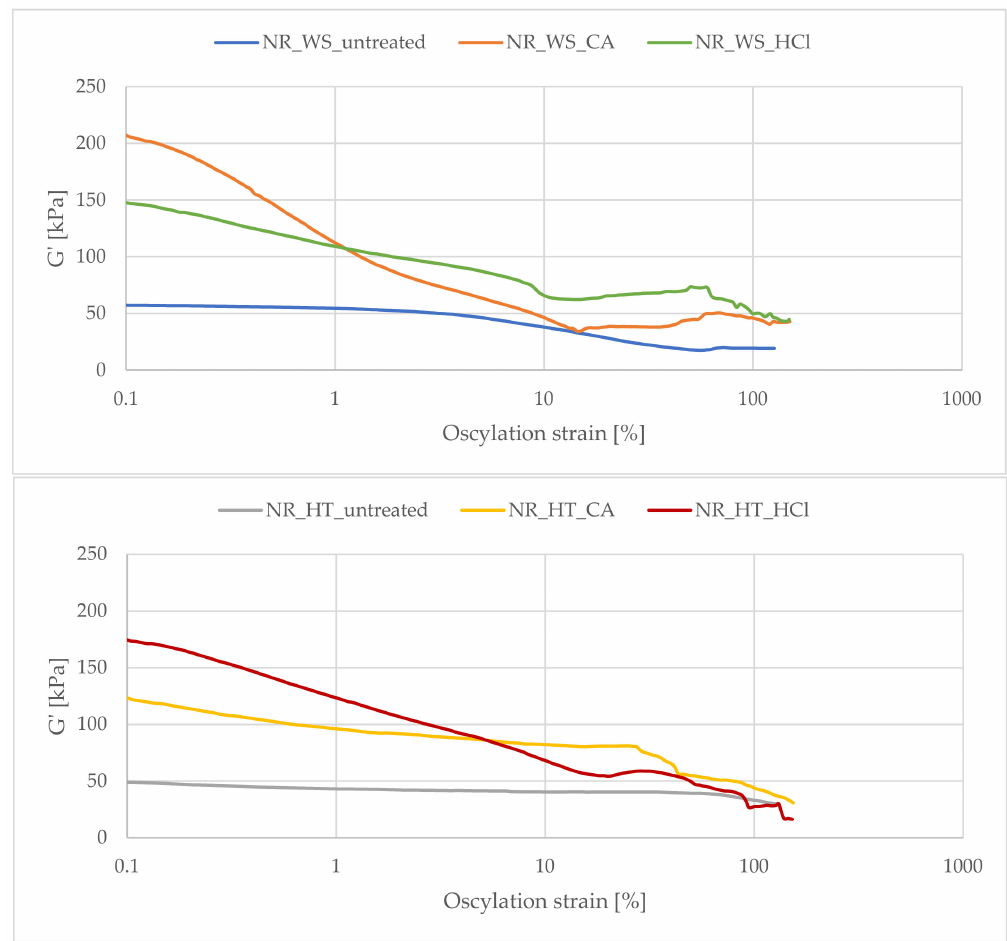
Figure 9. Payne effect (decrease of the storage modulus (G’) as a function of deformation) observed for filled